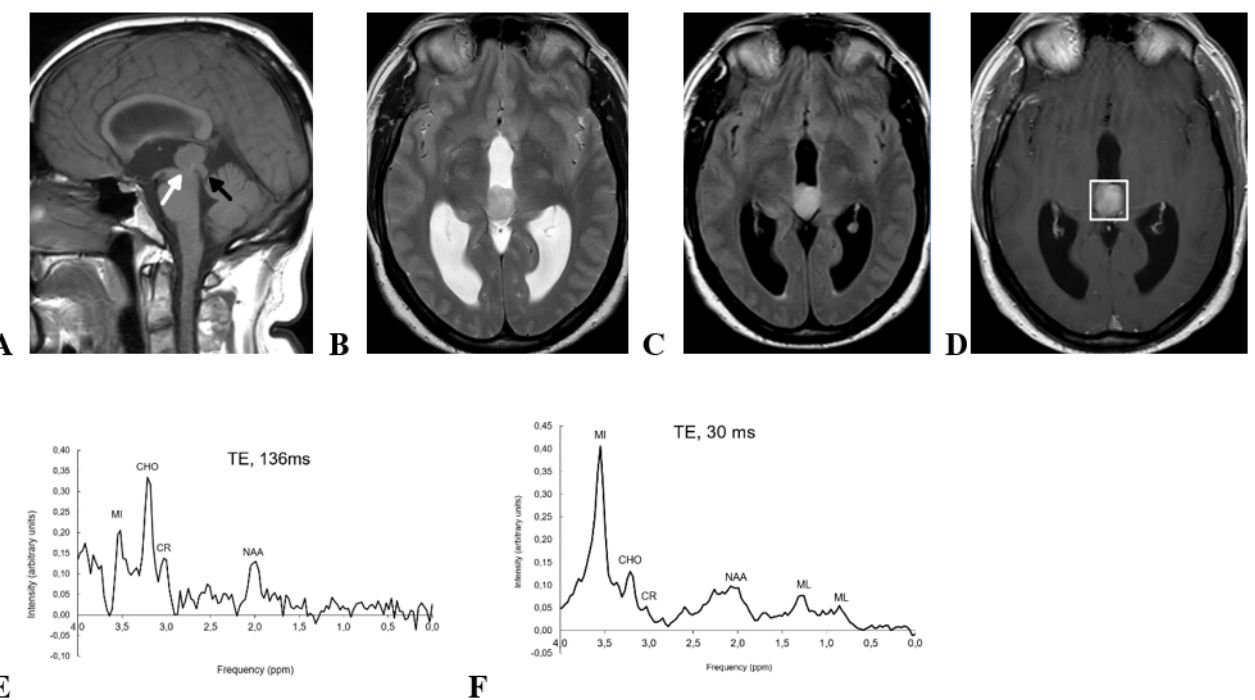
Figure 2. Preoperative MRI and 1H-MRS of a 52-yr-old man with pathology-confirmed PTPR. ( A ) Sagital T1-wi shows a homogeneous solid mass centered in the pineal region of intermediate intensity signal on this sequence. Note: midbrain tegmentum displacement (black arrow) and Sylvian aqueduct stenosis (white arrow). ( B ) Axial T2-wi and ( C ) Axial FLAIR-wi show that the mass is slightly hyperintense in both sequences. ( D ) Axial CET1-wi shows well defined margins of the mass are well-defined, and slightly inhomogeneous contrast enhancements. Voxel position for spectroscopy is shown. ( E ) Short TE 1H-MRS (TE, 30 ms) shows a huge myoinositol peak at 3.55 ppm. ( F ) Long TE 1H-MRS (TE, 136 ms) with signal loss at 3.55 ppm that confirms preponderant myoinositol contribution. MI, myoinositol; CHO, choline; CR, creatine; NAA, N-acetyl-aspartate; ML, mobile lipids.